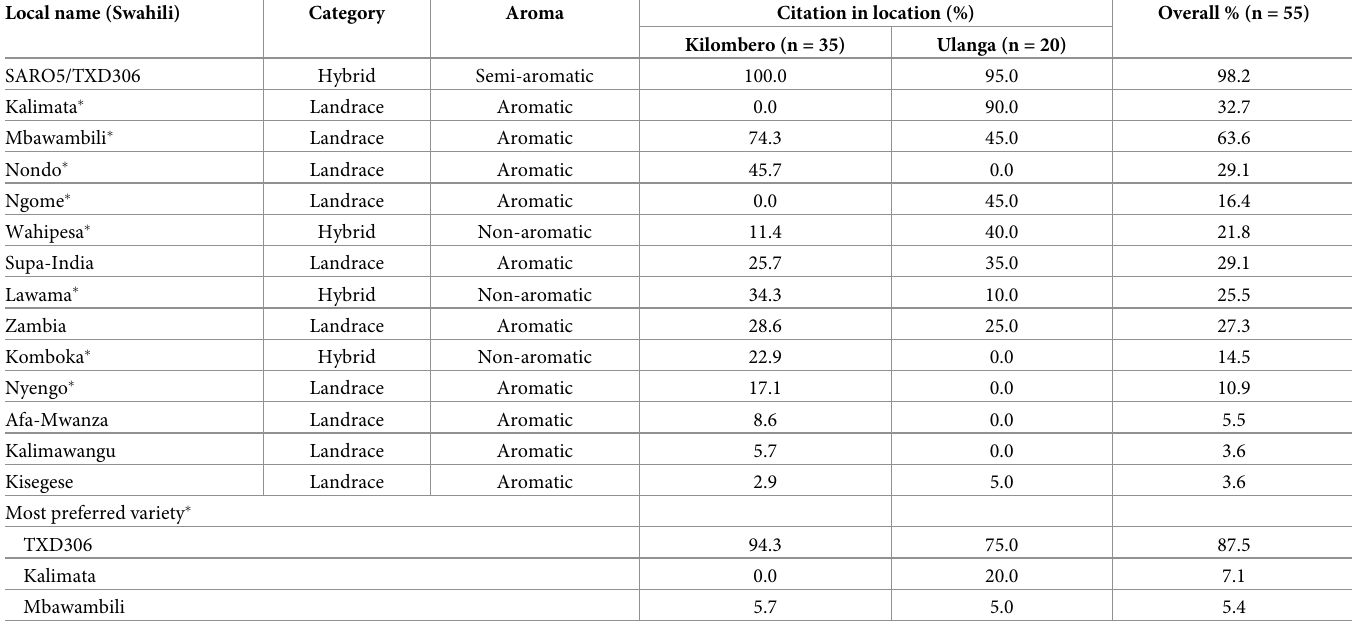
Table 6. Inventory of rice varieties commonly used for pepeta production in the surveyed